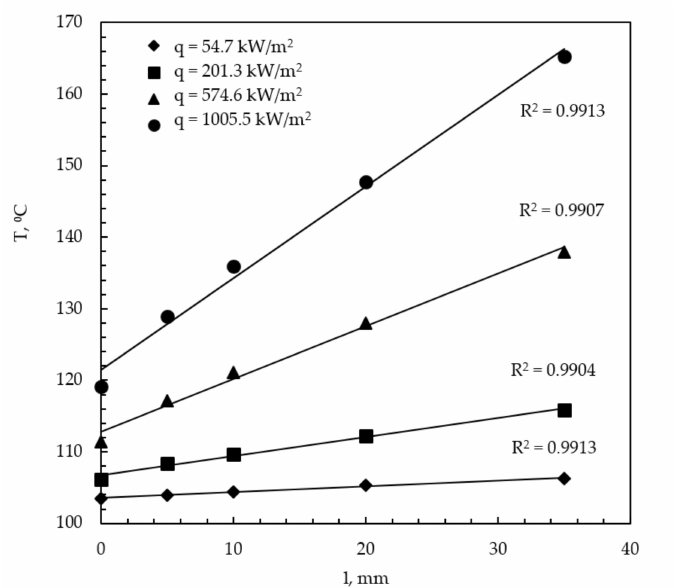
Figure 2. Temperature distribution at different heat fluxes: Specimen MC-0.3-0.4-0.6.